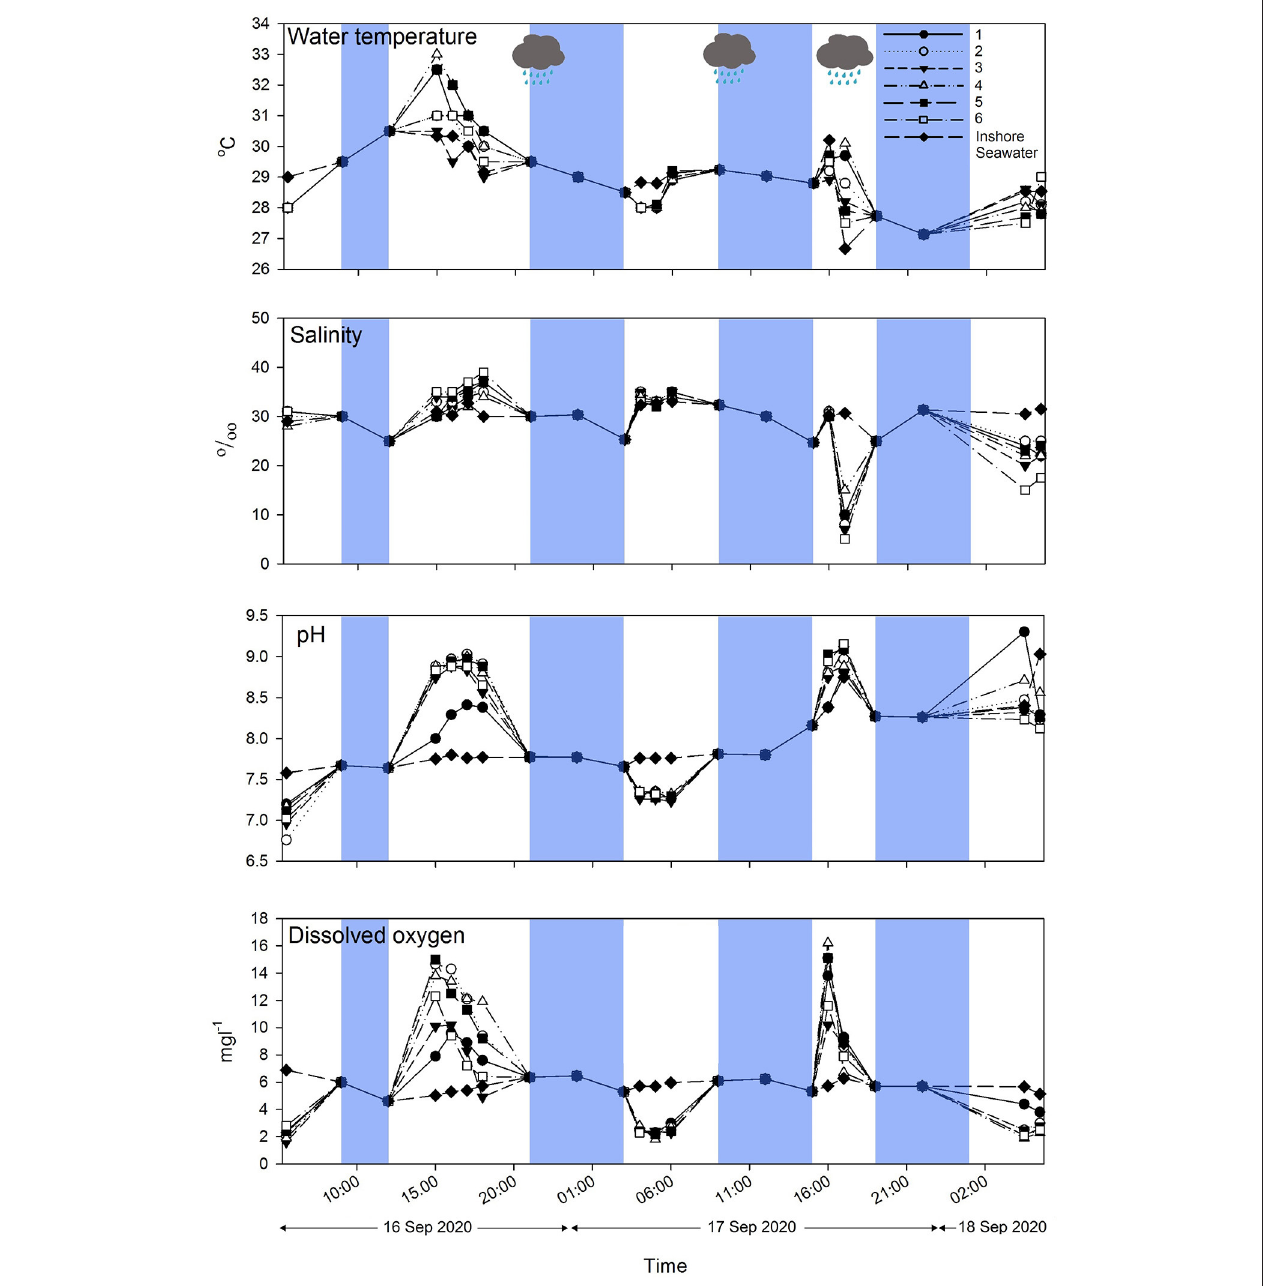
FIGURE 3 | Diurnal variation in water temperature, salinity, pH, and dissolved oxygen in six intertidal pools and inshore seawater. Blue regions indicate pools that were immersed in high tides. White regions indicate pools that were isolated from the sea during low tides. Raining clouds indicate that rain occurred during sampling.